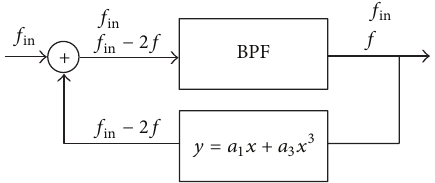
Figure 2: Model of a divide-by-three injection-locked frequency divider with a direct application of the forcing